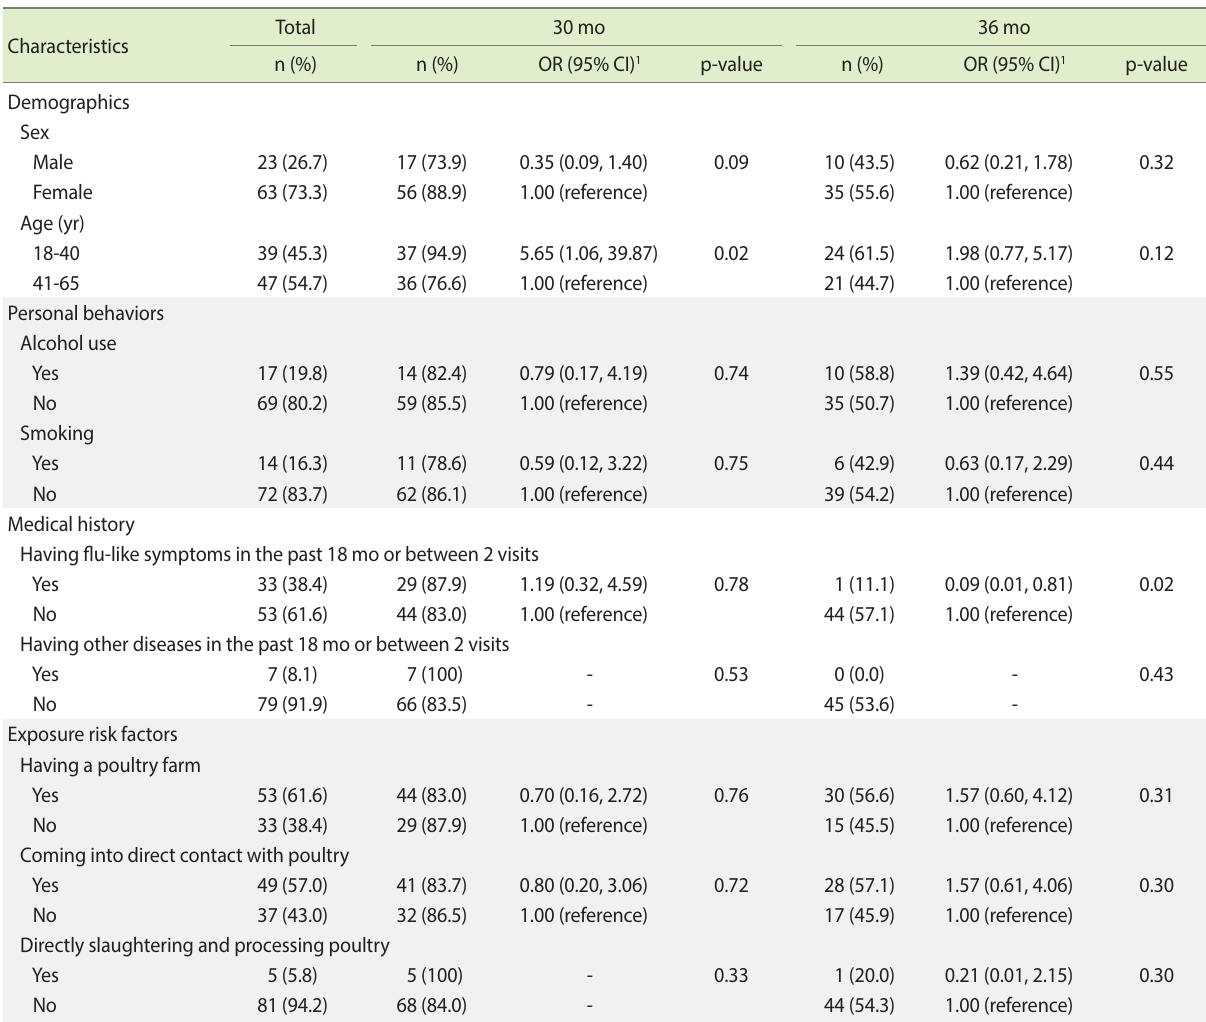
Table 2. Demographic characteristics, personal behaviors, medical history, and exposure risk factors for persistence of at least a 1/10 amount of A/H5N1 antibodies at 30 months and 36